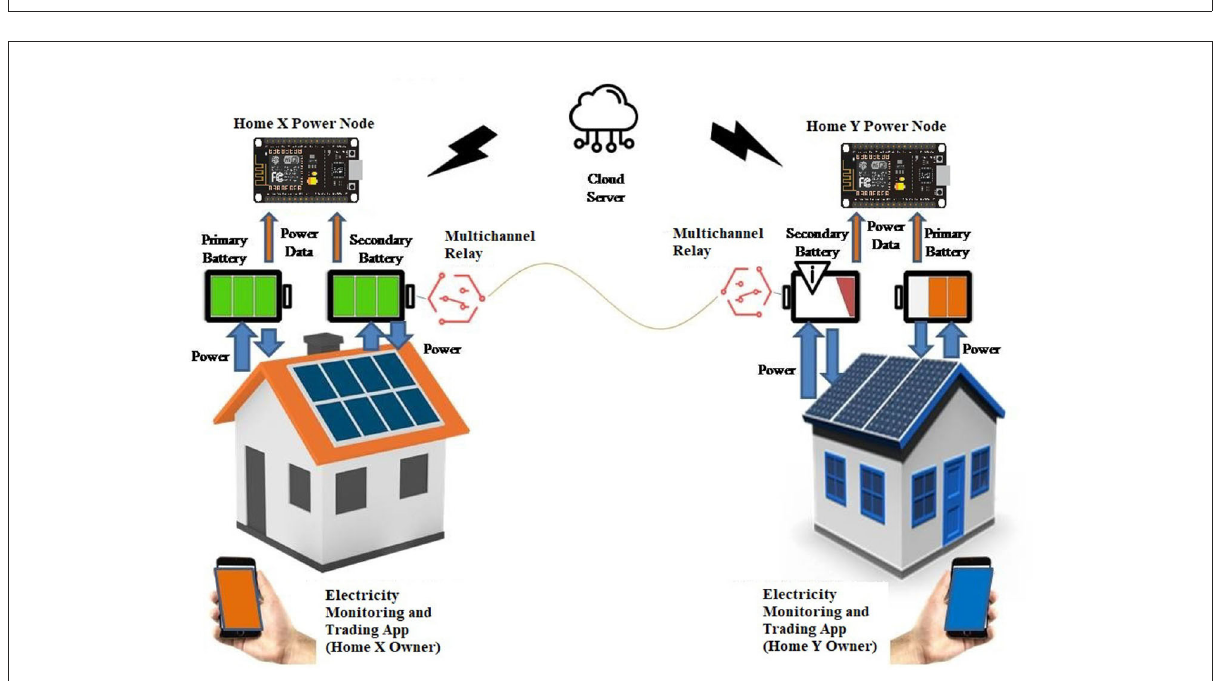
FIGURE11 Proposed architecture of IoT-based energy trading using solar system (Salvi et al., 2020).